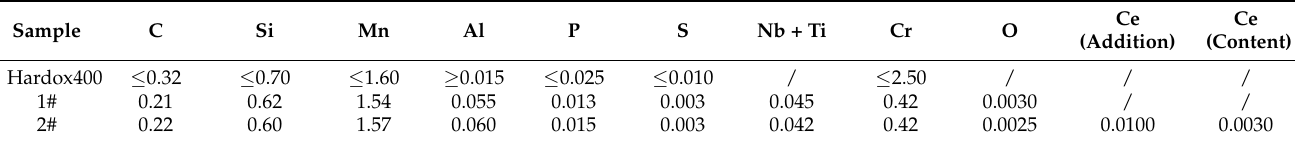
Table 1. Chemical composition of tested steels